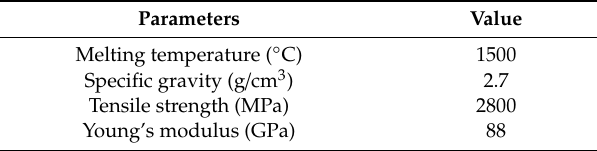
Table 2. Basalt microfiber (BMF)